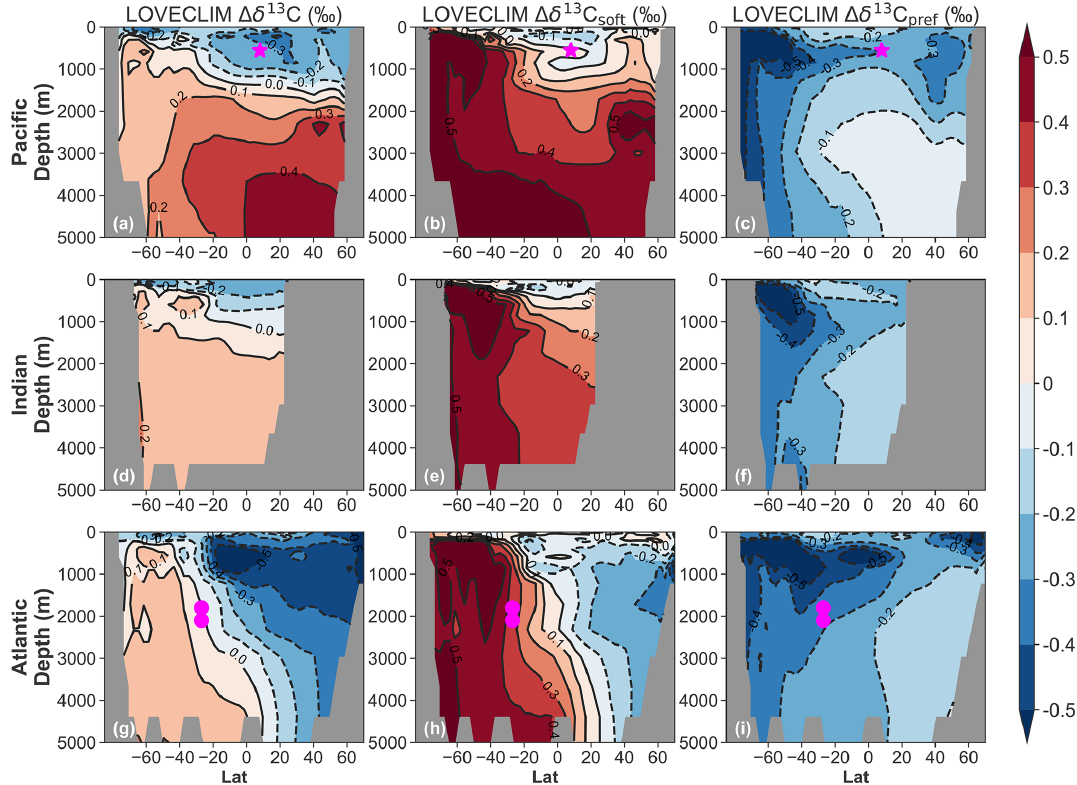
Figure 3. Ocean basin zonal mean anomalies (15ka minus 17.2ka) as simulated in LOVECLIM. (a–c) Pacific zonal mean anomaly (160 ◦ E– 140 ◦ W). The magenta star marks the GeoB17402-2 site. (d–f) Indian zonal mean anomaly (50–90 ◦ E). (g–i) Atlantic zonal mean anomaly (60–10 ◦ W). The magenta circles mark the 78GGC and 33GGC sites discussed in Sect.